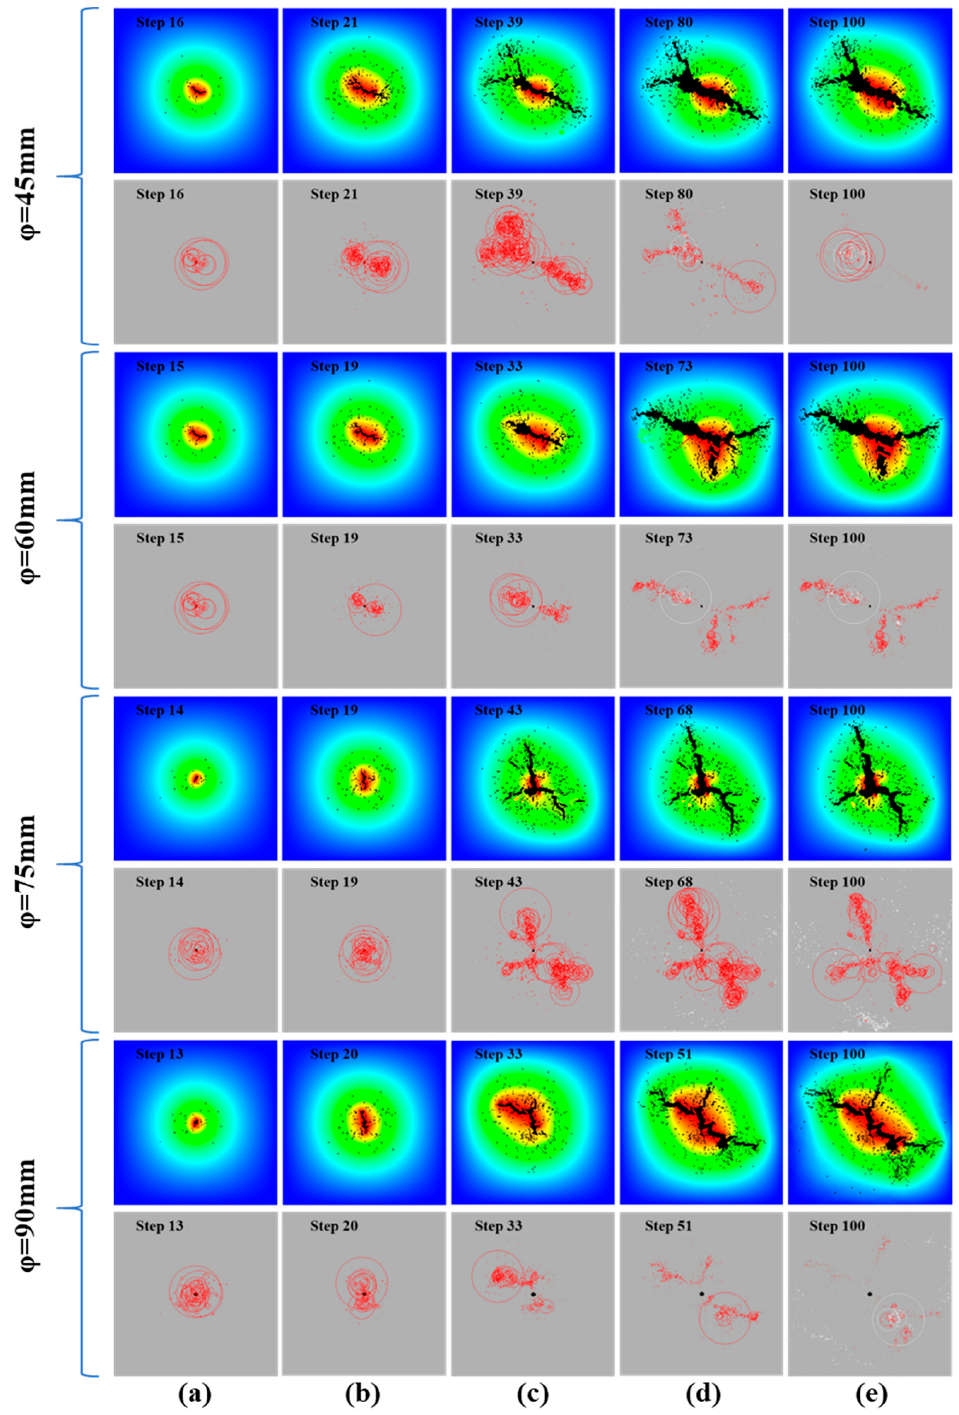
Figure 12. Pore water pressure and acoustic emission diagrams for different fracturing hole aper ‐ tures: ( a ) Hydraulic pressure accumulation stage, ( b ) micro ‐ fracture development stage, ( c ) micro ‐ fracture extension penetration stage, ( d ) fracture destabilization extension stage, ( e ) fracturing com ‐ pleted.